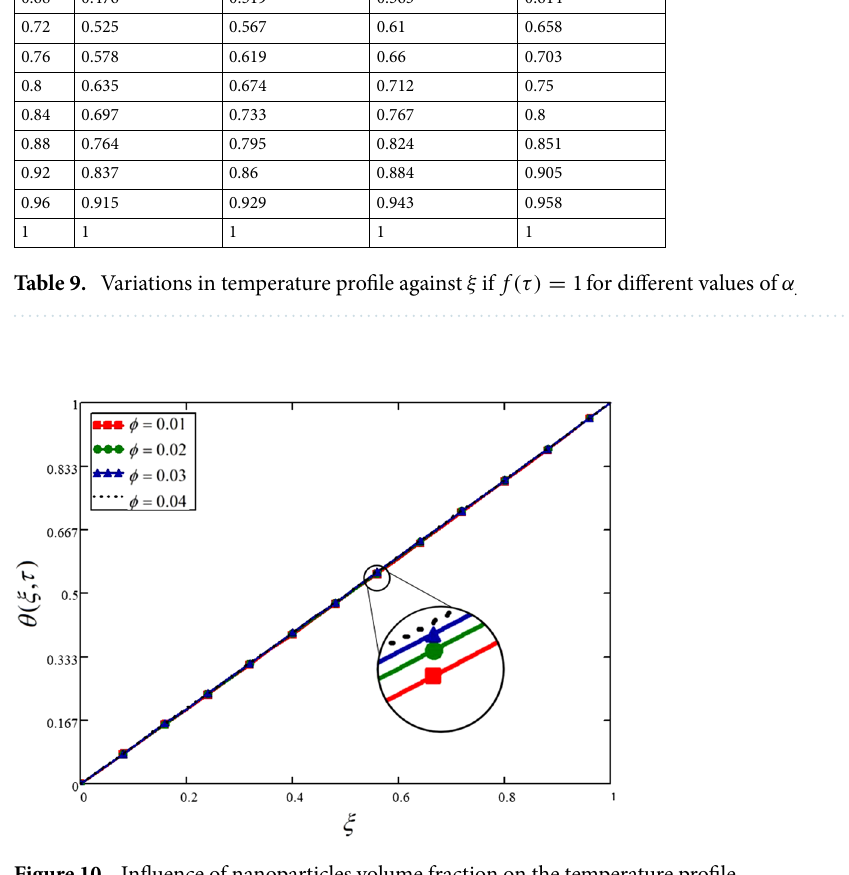
Figure 10. Influence of nanoparticles volume fraction on the temperature